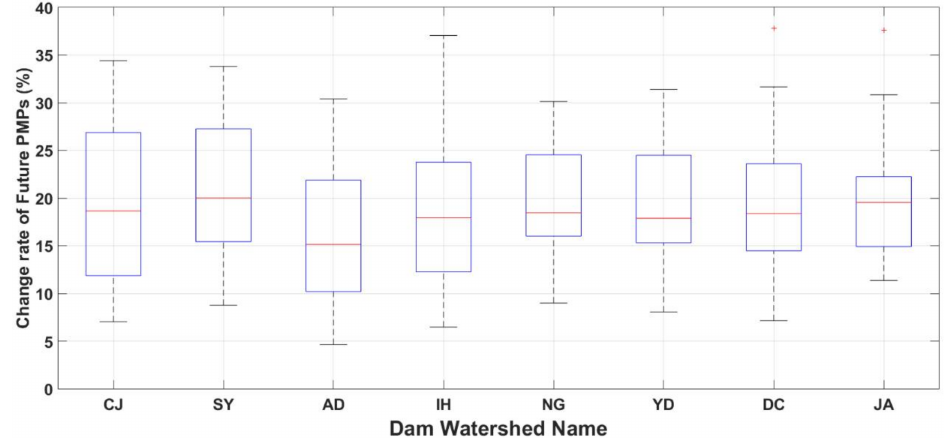
Figure 15. Rate of change of future PMPs at major dam watersheds in the future year 2050.